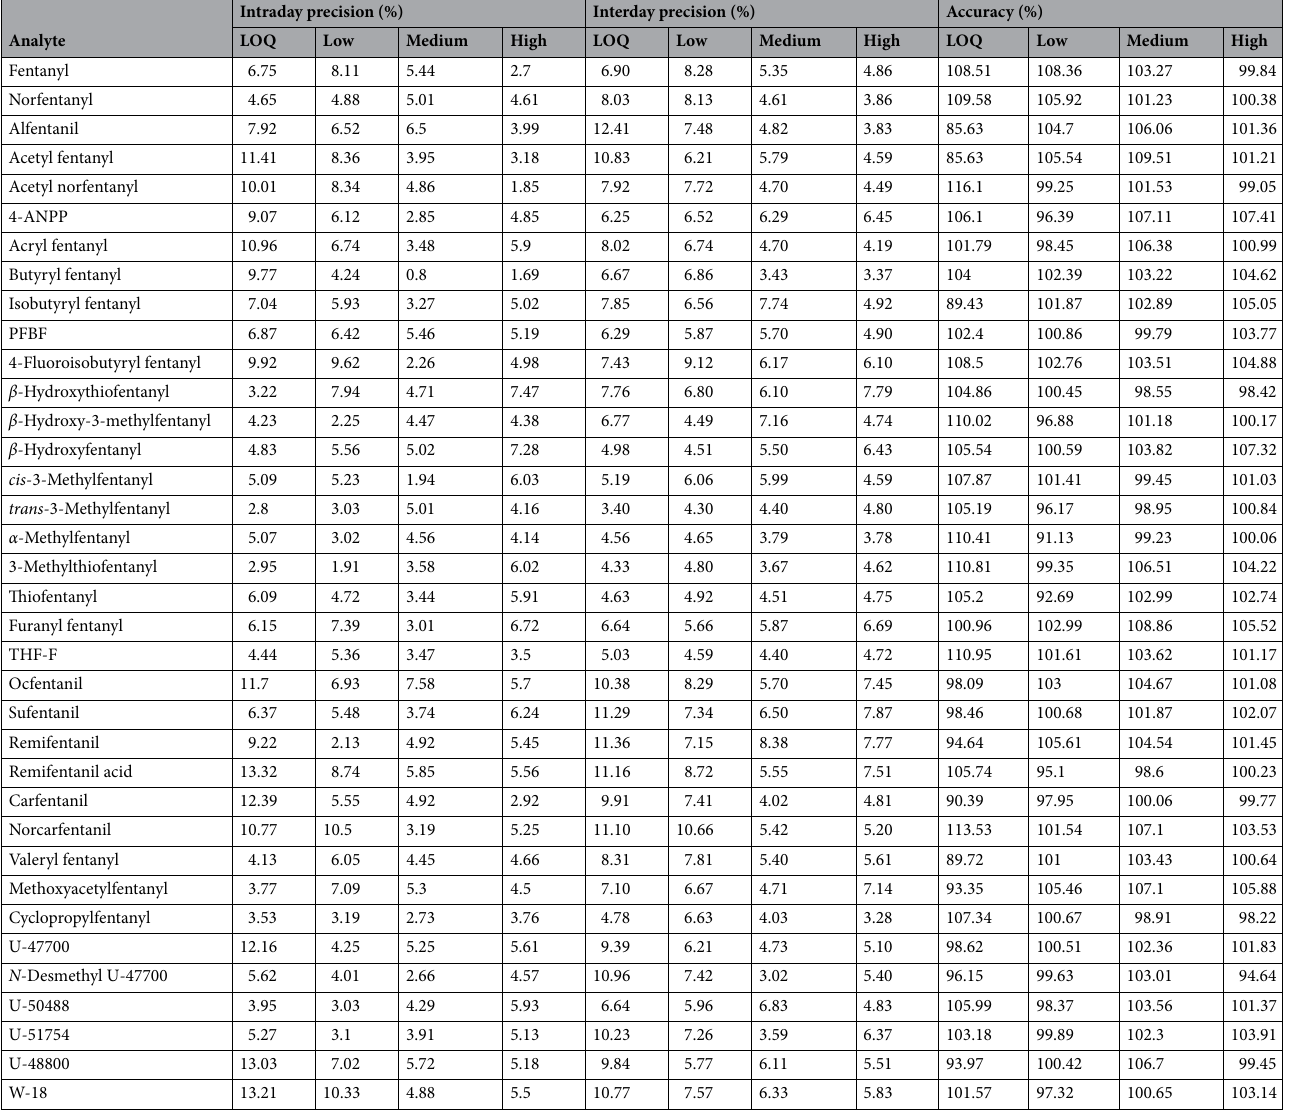
Table 4. Precision and accuracy for analytes in